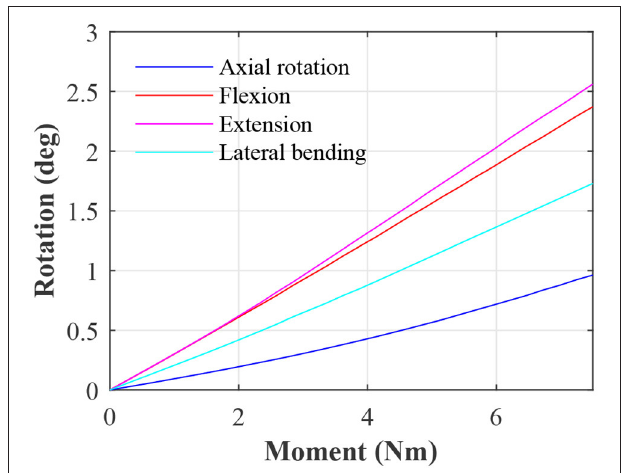
FIGURE 2 | Moment-rotation data for the IVD with default material